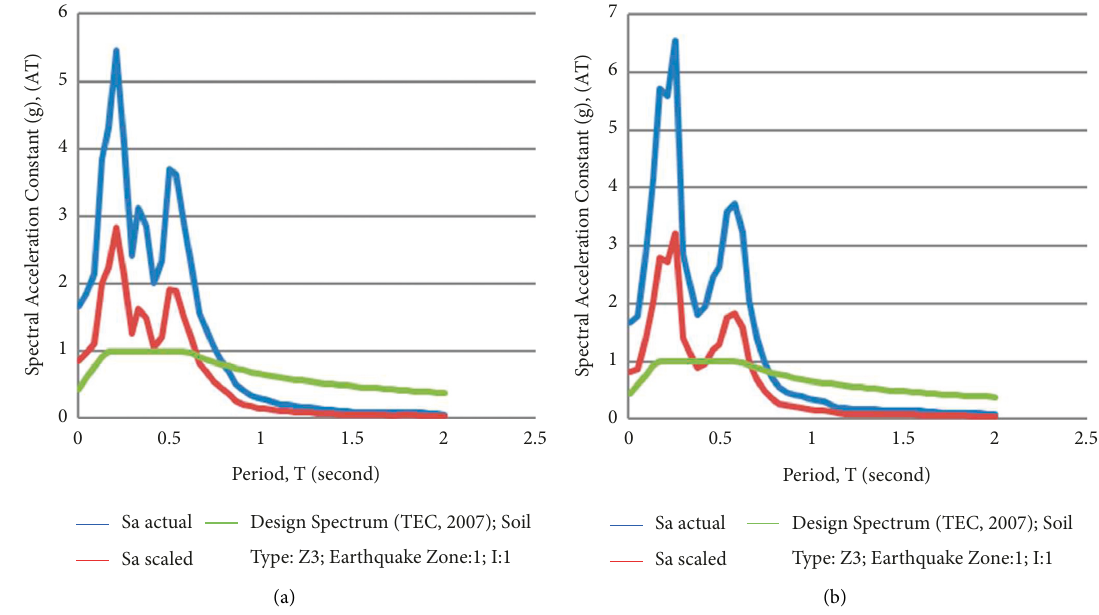
Figure 12: Evaluation of A(T) spectral acceleration constants for (a) North-South (N-S) and (b) East-West (E-W) components of earthquake with epicenter at Sivas ( M D : 4.5).